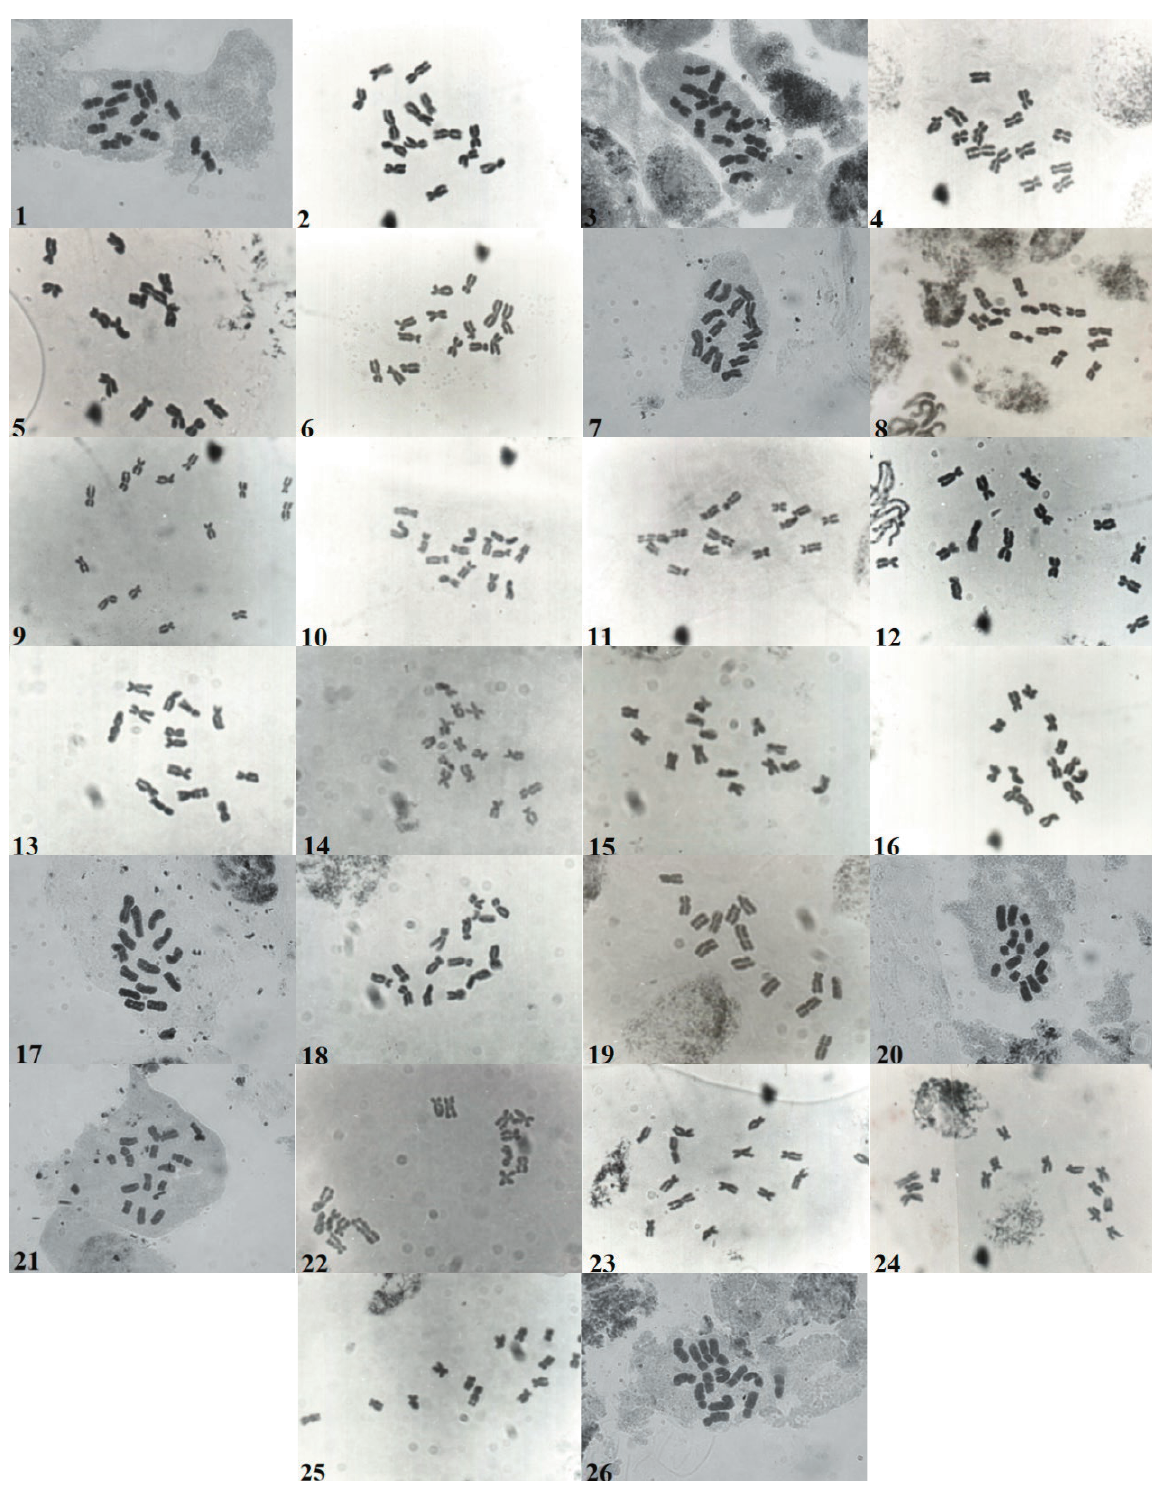
Figure 1. Mitotic metaphase chromosomes of Lathyrus taxa (1. L. brachypterus var. haussknechtii , 2. L. digitatus , 3. L. spathulatus , 4. L. pratensis , 5. L. laxiflorus subsp. laxiflorus , 6. L. tuberosus , 7. L. belinensis , 8. L. sphaericus , 9. L. inconspicuus , 10. L. tauricola , 11. L. setifolius , 12. L. annuus , 13. L. gorgoni var. gorgoni , 14. L. cicera , 15. L. sativus , 16. L. stenophyllus , 17. L. phaselitanus , 18. L. hirsutus , 19. L. chloranthus, 20. L. clymenum , 21. L. ochrus , 22. L. nissolia , 23. L. aphaca var. affinis , 24. L. aphaca var. pseudoaphaca , 25. L. aphaca var. modestus , 26. L. odoratus